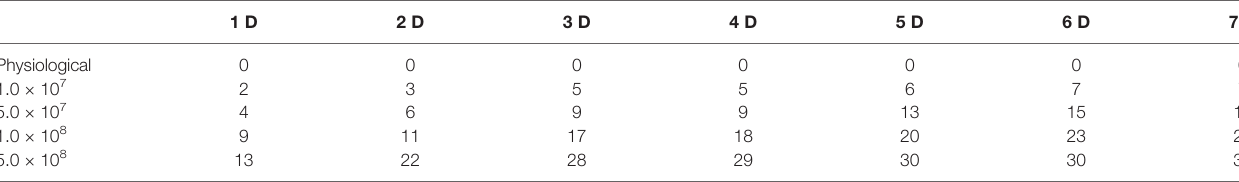
TABLE 2 | Death statistics of C. carpio infected with P. shigelloides